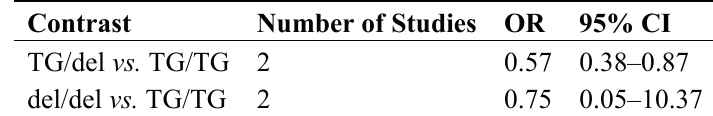
Table 6. Multivariate meta-analysis for the 1527–1528 TG>del polymorphism of the CD24 gene with MS.